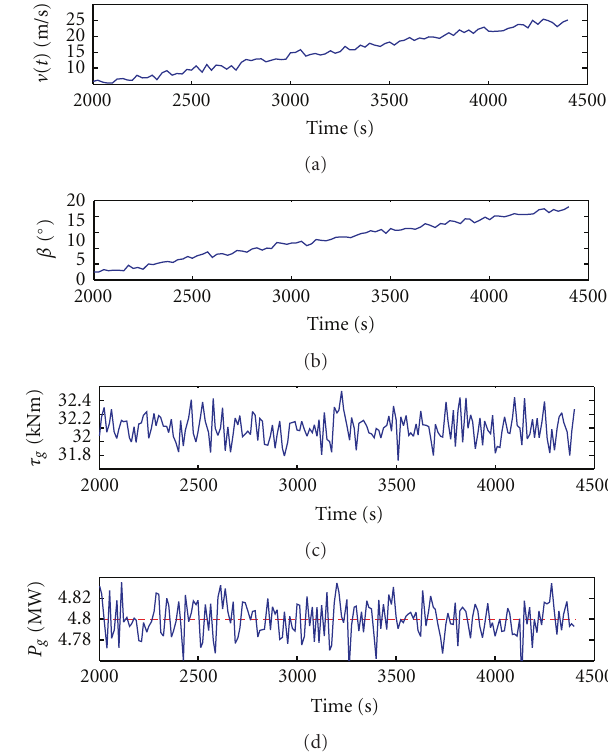
Figure 6: Simulations of the wind turbine benchmark operating at full